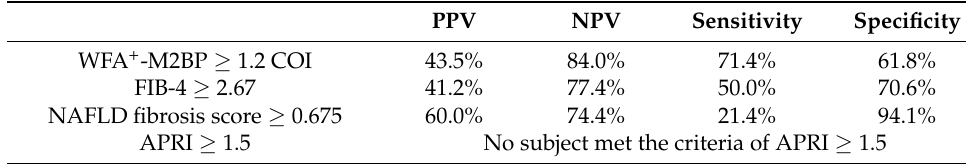
Table 2. The diagnostic accuracy of serum fibrosis markers for significant fibrosis.